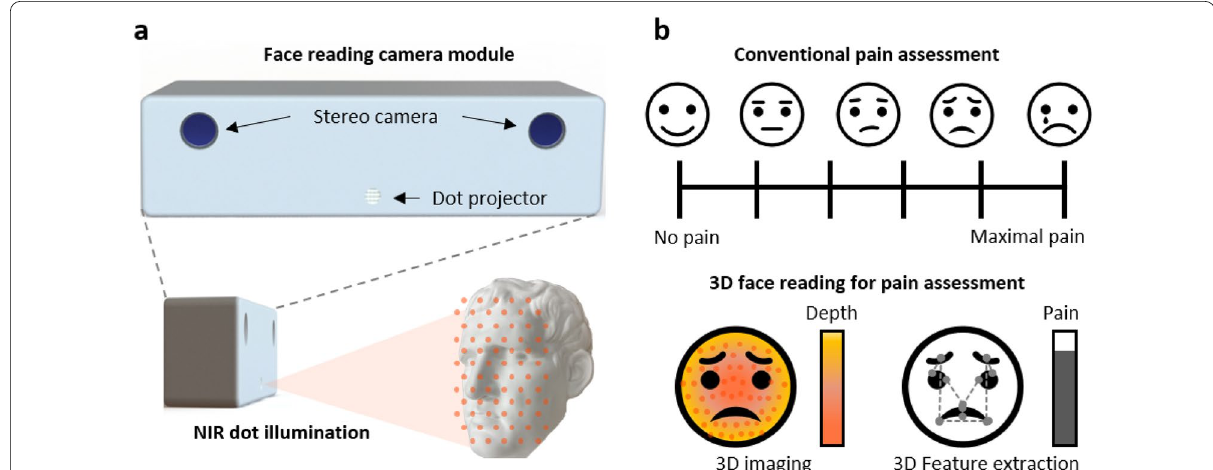
Fig. 1 Schematic illustrations of quantitative painrating using a face reading camera module (FRCM). a Concept of 3D face imagingwith the FRCM. A stereo camera is used to obtain depth information of a face.NIR dot projection enhances the performance of stereo matching. b Anillustration of conventional pain metric and pain assessment using the FRCM.The FRCM measures pain intensity using changes of facial expression whileconventional methods generally depend on